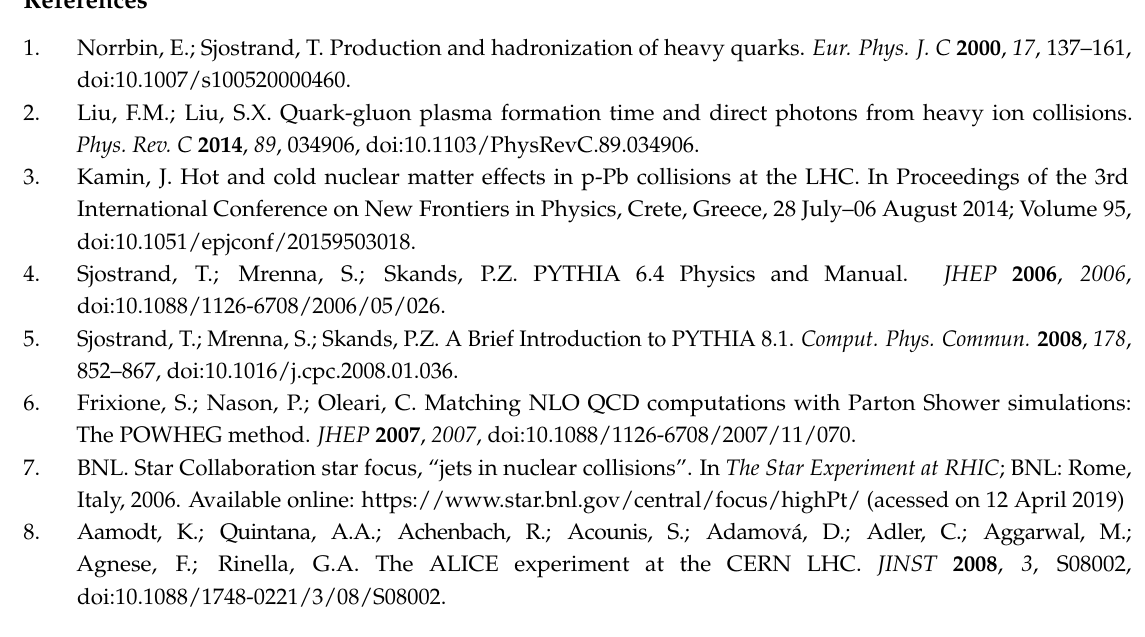
Figure 4. Comparison of NS yield and Gaussian width ( σ NS ) for pp data at √ s NN = 5.02 data at